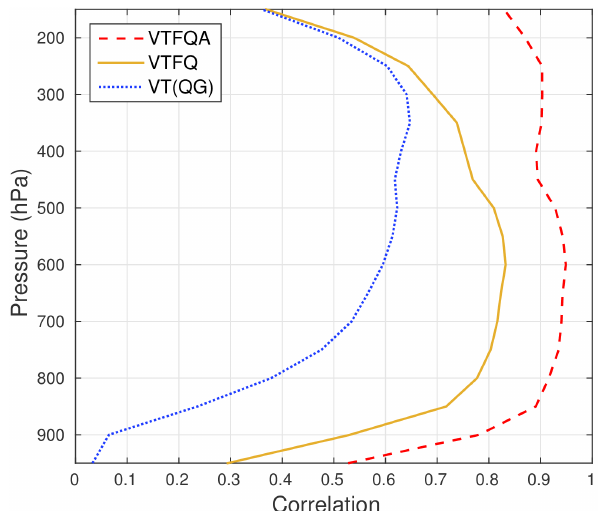
Figure 3. Correlation of the omega equation solutions with ω WRF .